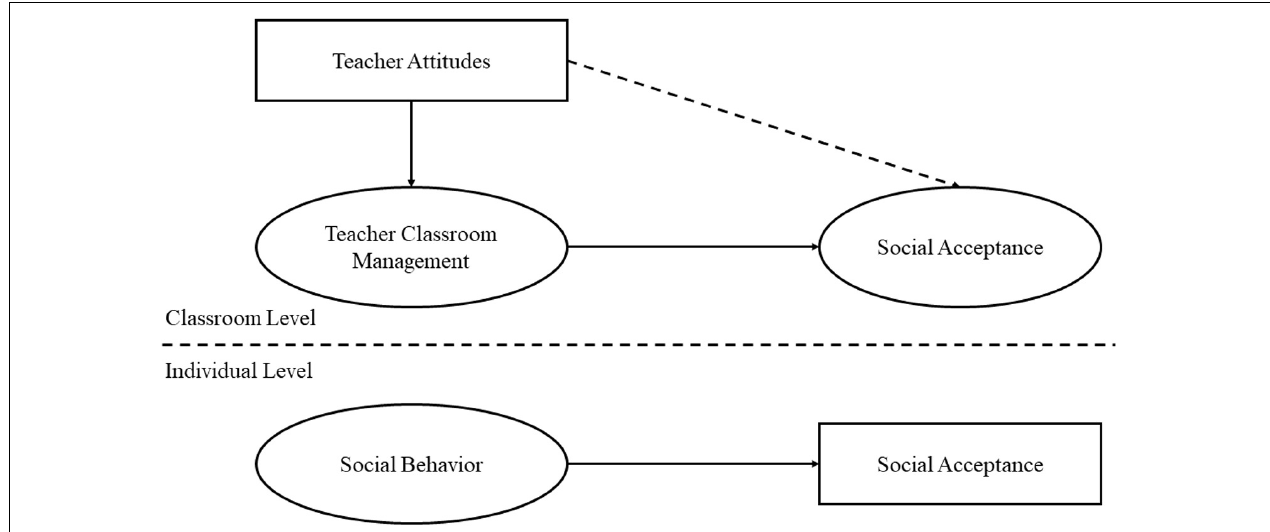
FIGURE 1 | Hypothesized Model. Solid arrows represent hypothesized effects. Dashed arrows depict paths that are expected to be 0. On the individual level, student social behavior is assumed to predict student social acceptance. On the classroom level, teacher attitudes are hypothesized to predict teacher classroom management, but to have no direct effect on student social acceptance. Teacher classroom management, however, is expected to be a significant predictor of student social acceptance on the classroom level. Teacher attitudes are assumed to only affect students’ social acceptance indirectly (mediated by teacher classroom